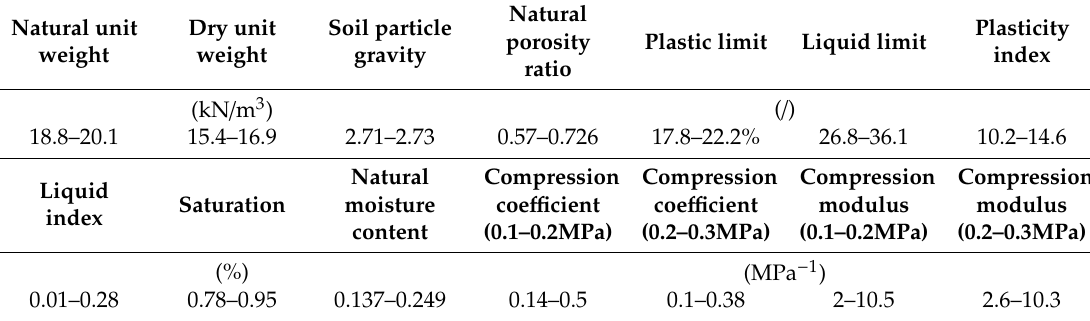
Table 1. Physical properties of landslide soil.